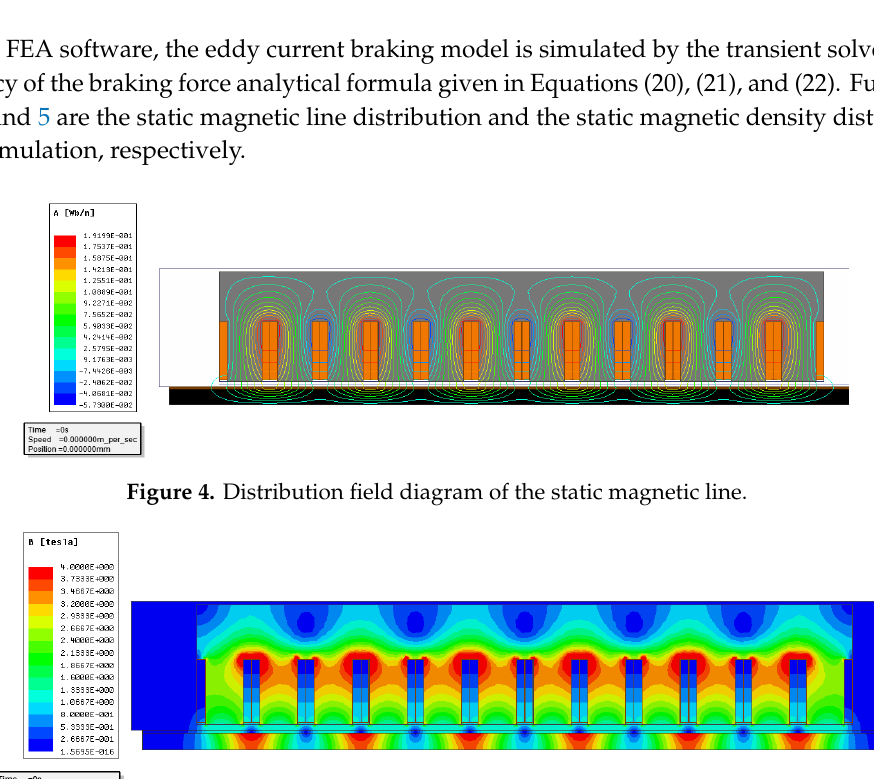
Figure 3. FEA model of eddy current braking.